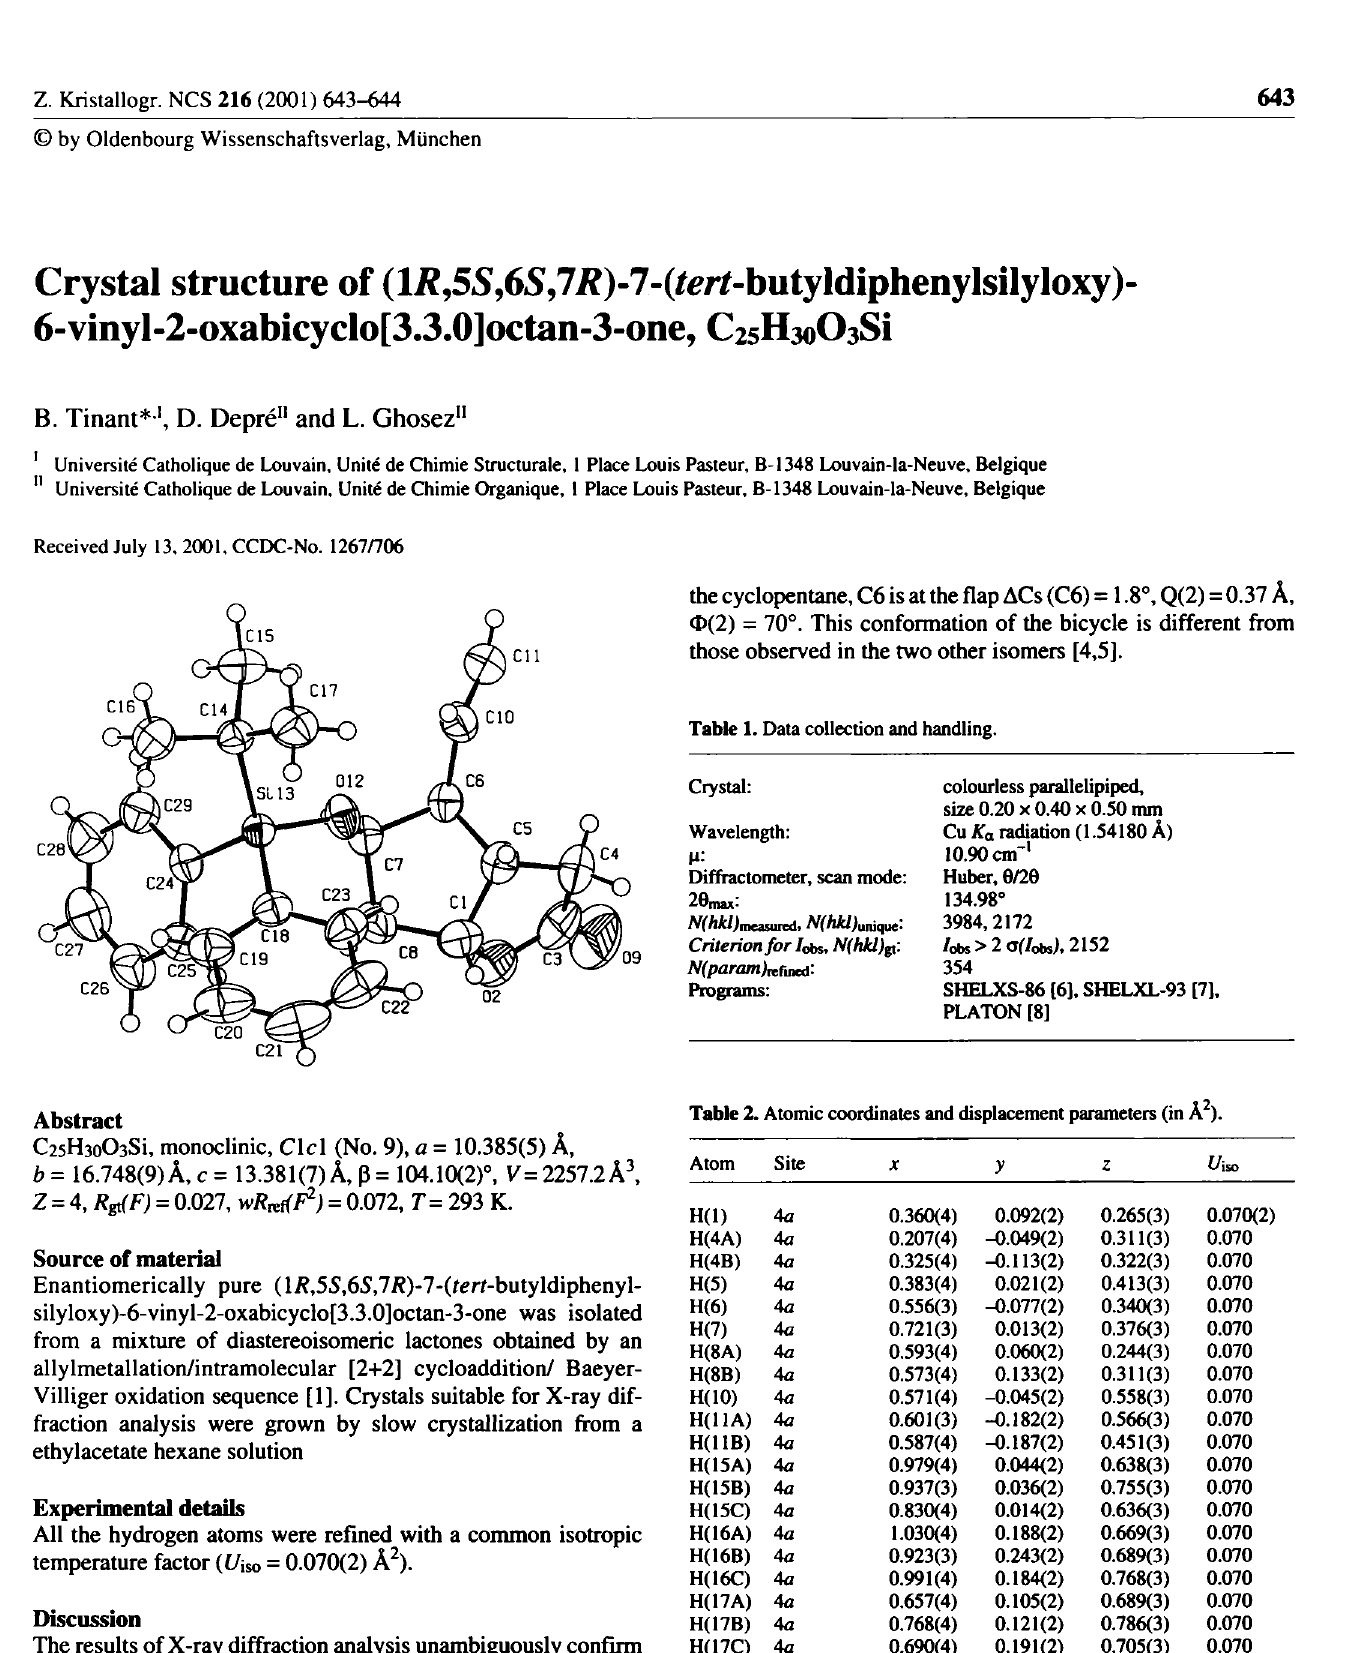
Table 2. Atomic coordinates and displacement parameters (in A 2